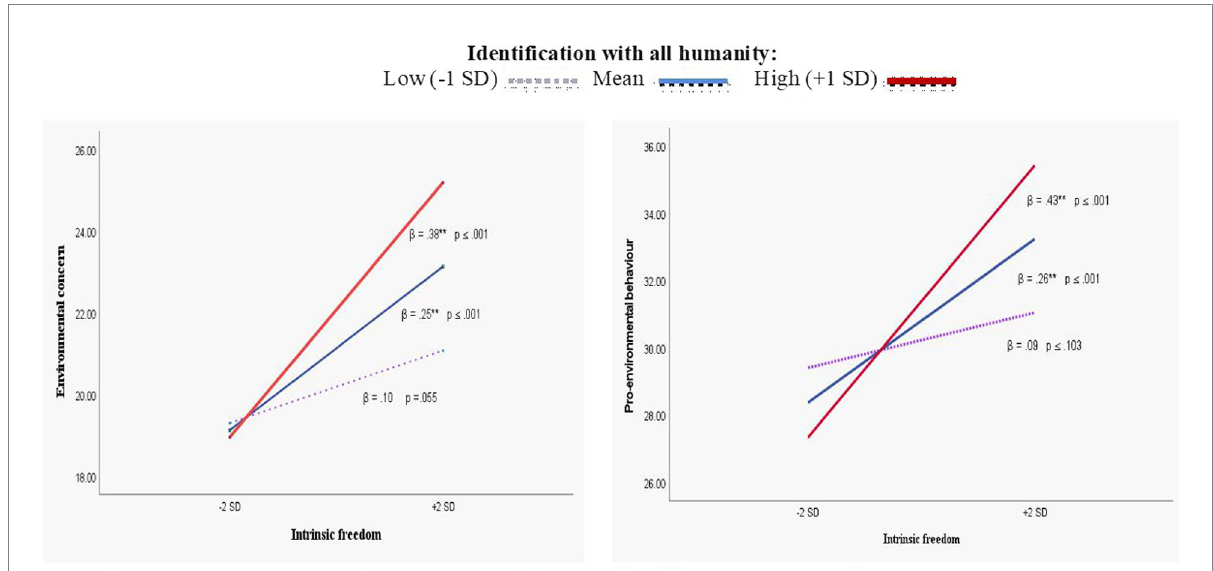
FIGURE 1 Synergistic effects of identification with all of humanity on the positive relationship between intrinsic freedom, environmental concern an pro- environmental behavior (Model 1).